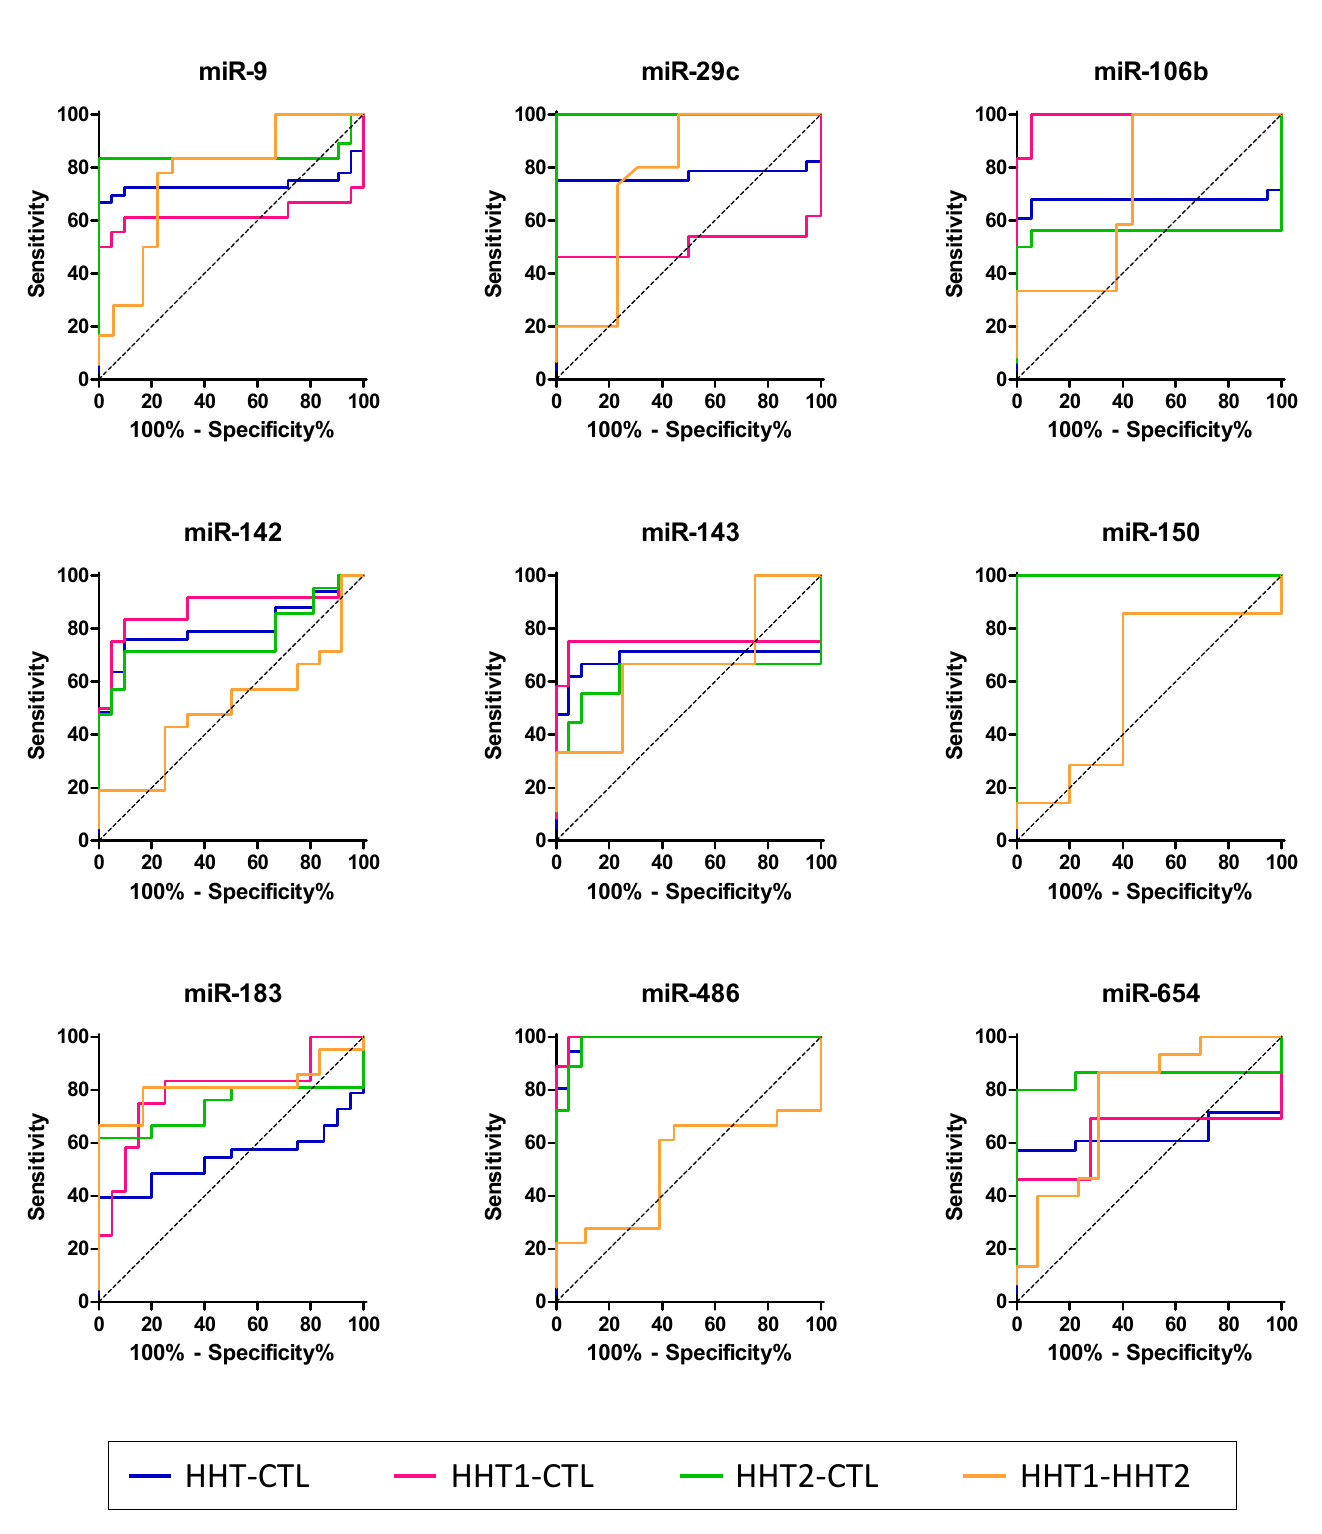
Figure 5. Analysis of the area under the ROC curves (AUC). ROC curves were calculated for the 95% confidence interval. Of note, the color of some ROC curves—for example, in miR-150—is missing due to overlapping with others (see Table 2 for AUC values).